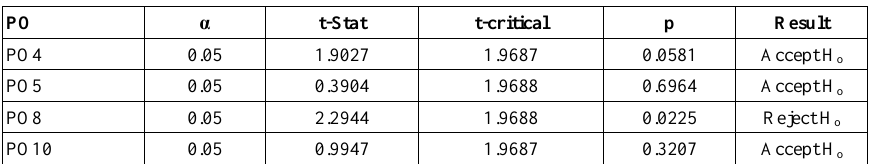
Table 6. T-test Result